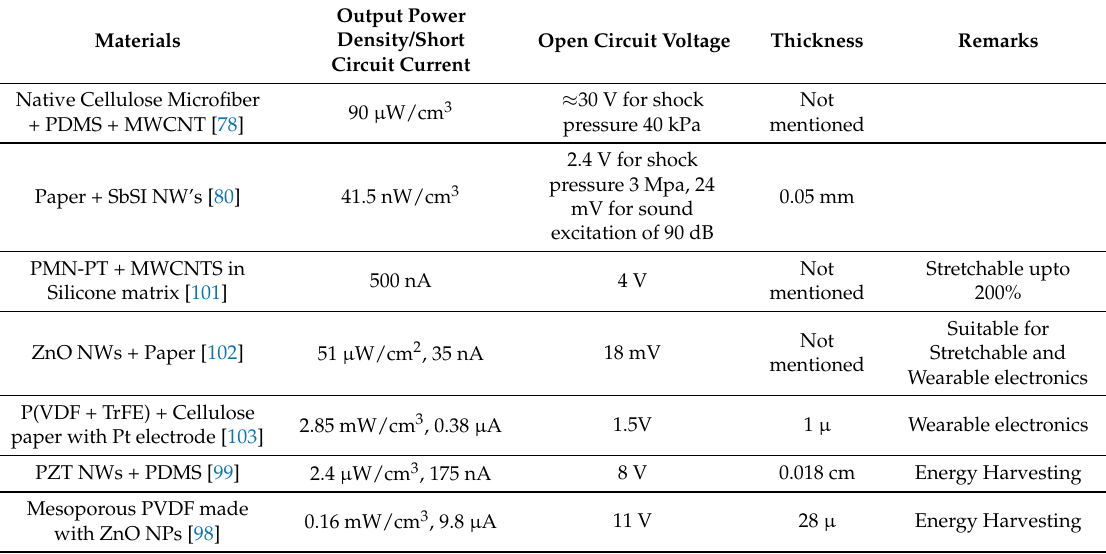
Table 6. Recent developments in energy